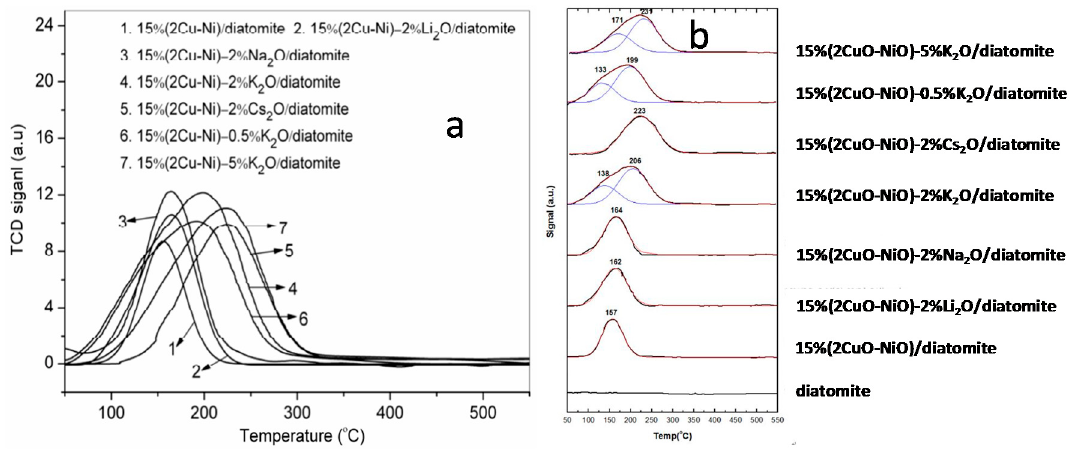
Figure 7. CO 2 Temperature-programmed desorption curves ( a ) and their fitting curves ( b ) of the samples. Table 1. Quantification of the CO 2 -TPD profiles of as-prepared catalysts.